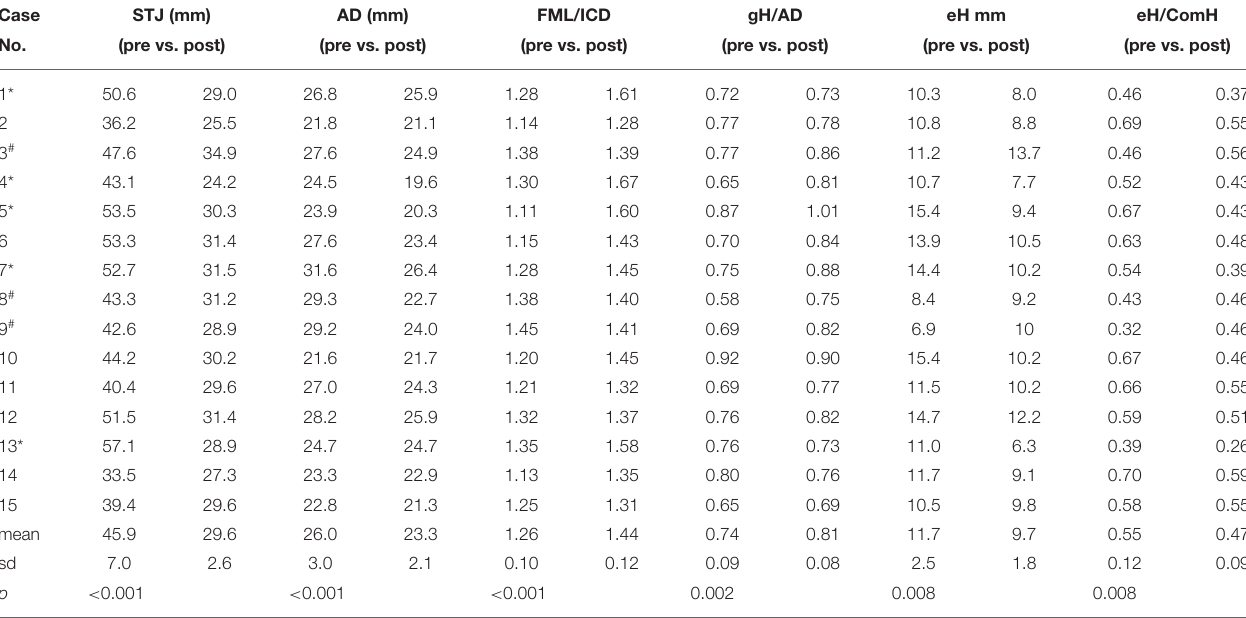
TABLE 3 | Statistical comparison and detailed pre- and post-operative leaflet-root parameters of 15 aortic valve repair cases.